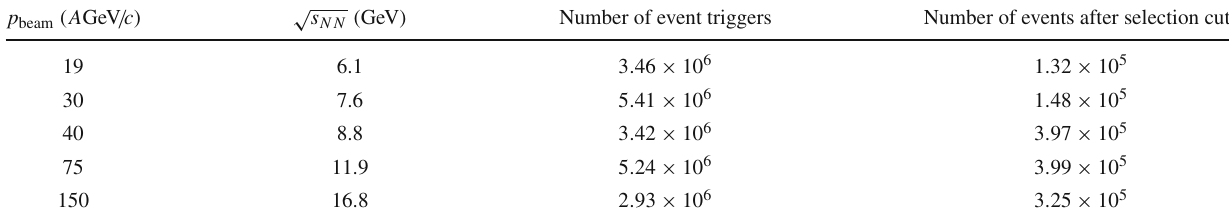
Table 1 Basic beam properties and number of events recorded and used in the analysis for Be+Be interactions of the 20% most central collisions √ p beam ( A GeV / c ) s NN ( GeV